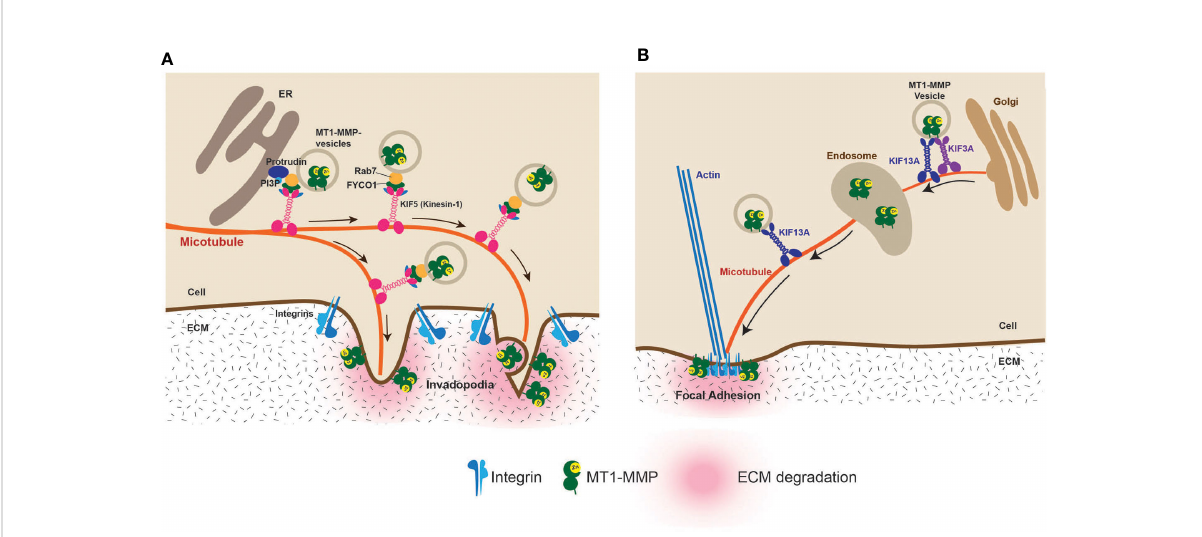
FIGURE 4 Vesicle transport of MT1-MMP to the invadopodia and the focal adhesion (FA). (A) Vesicle transport of MT1-MMP to the invadopodia has been extensively studied. It was shown that the endoplasmic reticulum protein protrudin plays a crucial role. Protrudin makes contact sites with RAB7 and phosphatidylinositol 3-phosphate (PI3P) – positive MT1-MMP-containing vesicles. Protrudin hands over RAB7-binding KIF5 adaptor protein FYCO1, enabling the transport of MT1-MMP-containing vesicles along microtubules toward invadopodia (32). (B) It was found that localization at FA is due to the direct transport of MT1-MMP-containing vesicles along the microtubules. KIF3A and KIF13A transport the vesicles between the trans-Golgi and the endosome. From the endosome, KIF13A solely transports the vesicles to the plasma membrane. The FA localization of MT1- MMP is essential for the HT1080 cell invasiveness